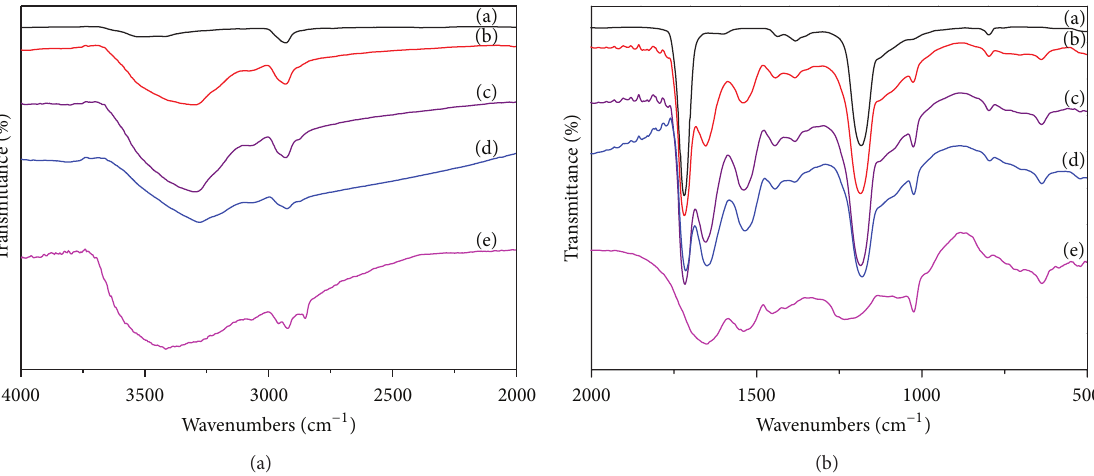
Figure 5: FTIR spectra of (a) electrospun PVA and (e) keratin powder as well as the blend nanofibers obtained using various weight ratios of keratin to PVA: (b) 50/50, (c) 60/40, and (d)